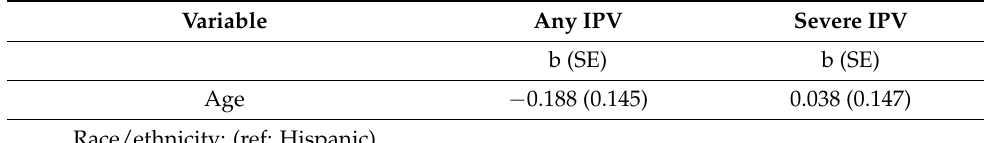
Table 3. Correlates of IPV frequencies among men ( n = 424 in 148 Census